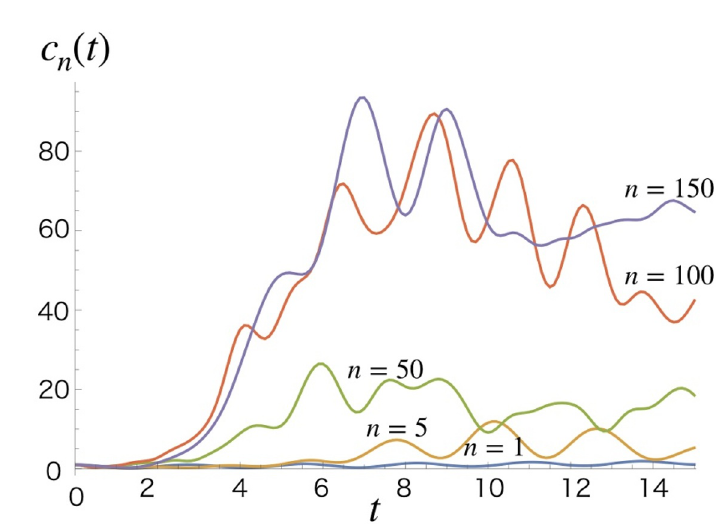
Figure 4 . Numerical results of the microcanonical OTOC of the CHO Hamiltonian system for the energy level n = 1 ; 5 ; 50 ; 100 ; 150. As a naive observation from the plot, the lowest mode n = 1 appears to be similar to that of the harmonic